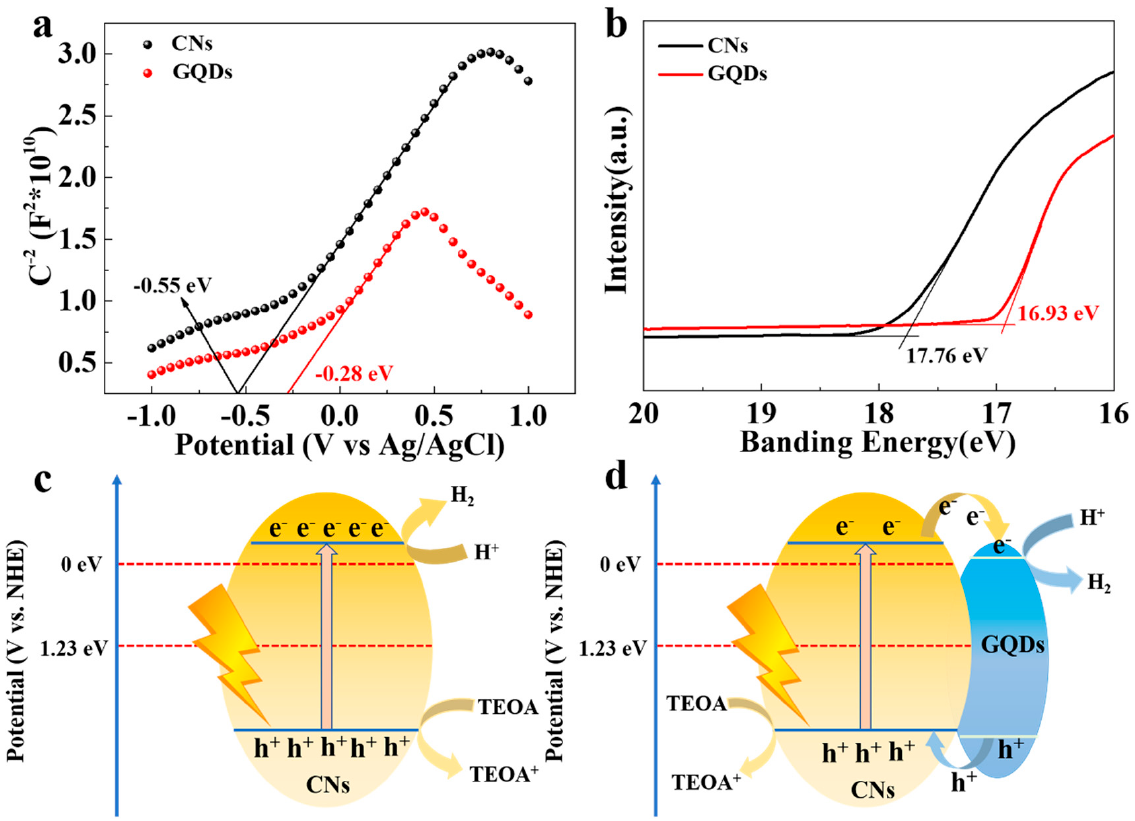
Figure 5. ( a ) Mott–Schottky curves of CNs and GQDs; ( b ) Ultraviolet photoelectron spectroscopy (UPS) of CNs and GQDs. The photocatalytic mechanism of ( c ) CNs and ( d ) CNs/GQDs.